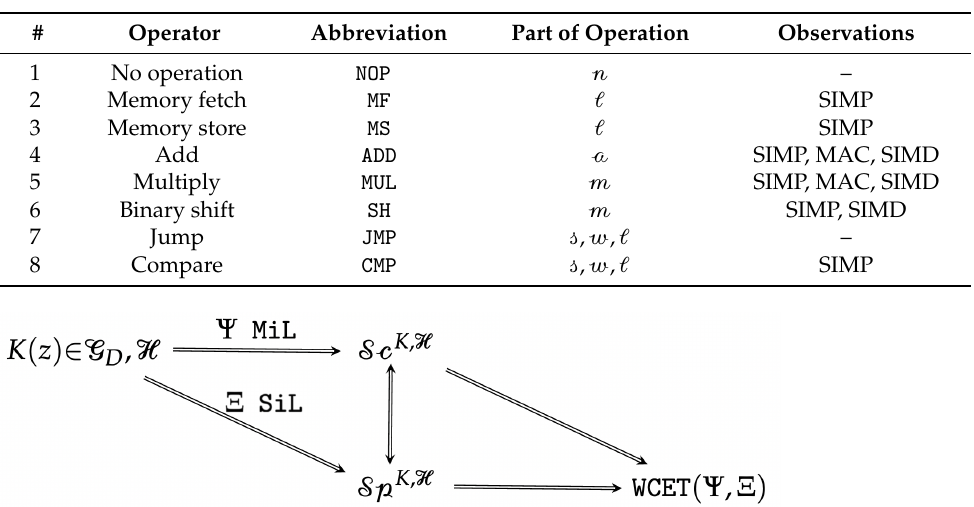
Table 2. Base assembly operations a i ∈ (cid:65) for a Random-Access Machine model used in an LTI-based control system context.